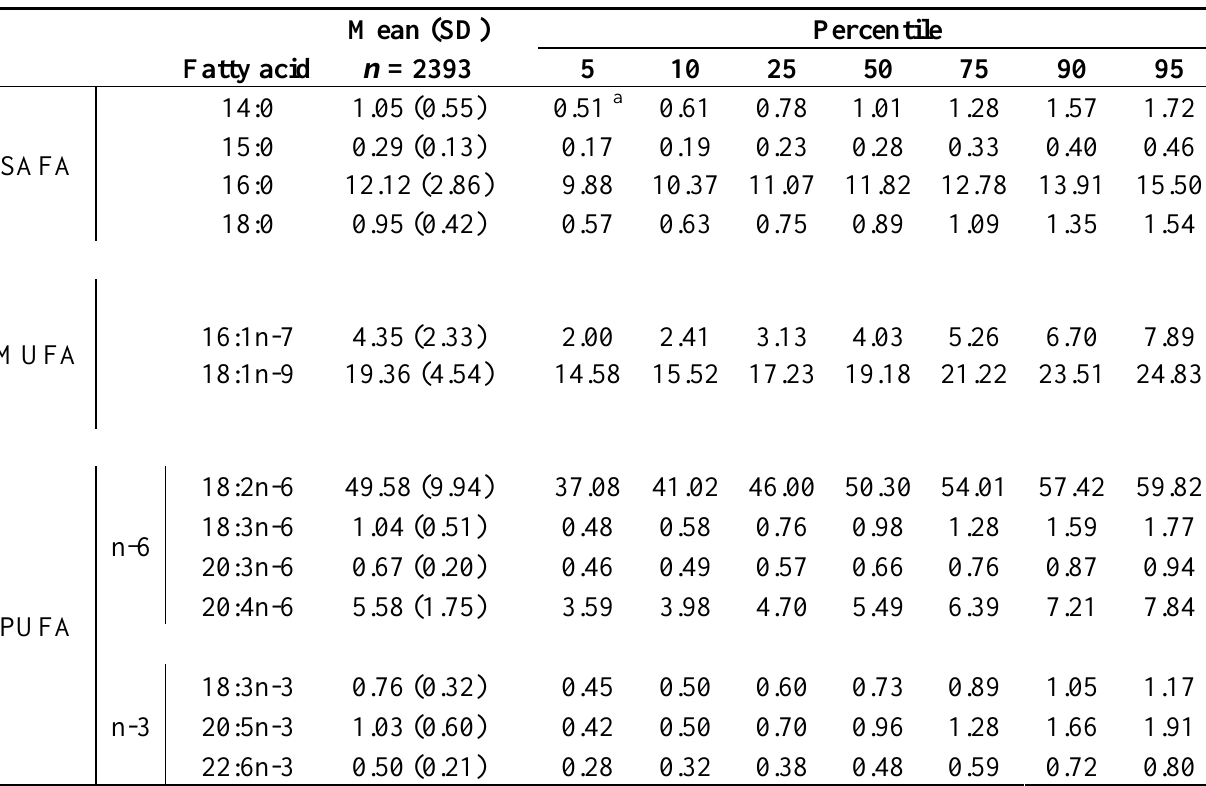
Table 3. National Nutrition Survey participant percentiles for serum cholesterol ester fatty acid composition.